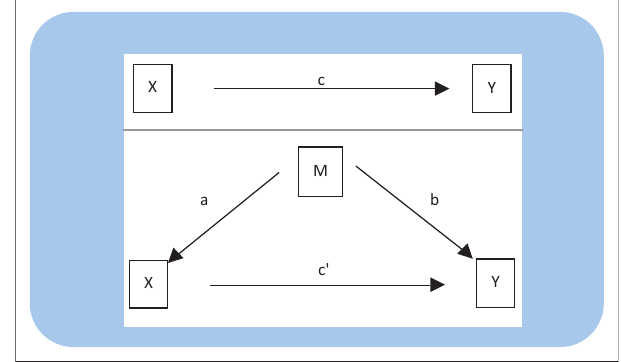
FIGURE 2: Framework for mediation analysis 47